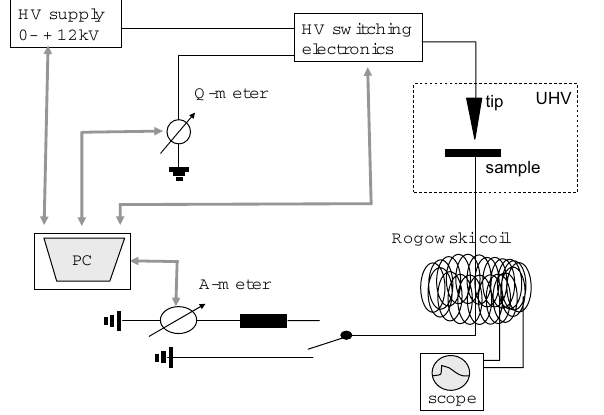
FIG. 1. Schematic view of the experimental